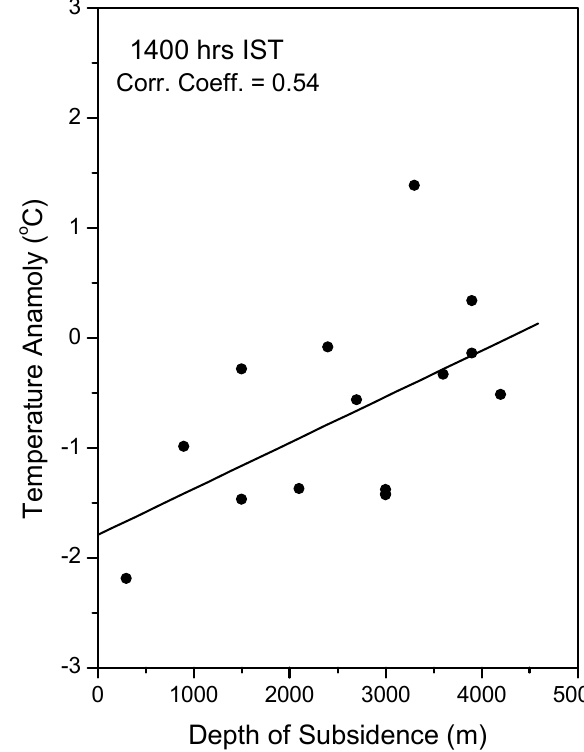
Fig. 7. Scatter plot of temperature anomaly and depth of subsidence during March